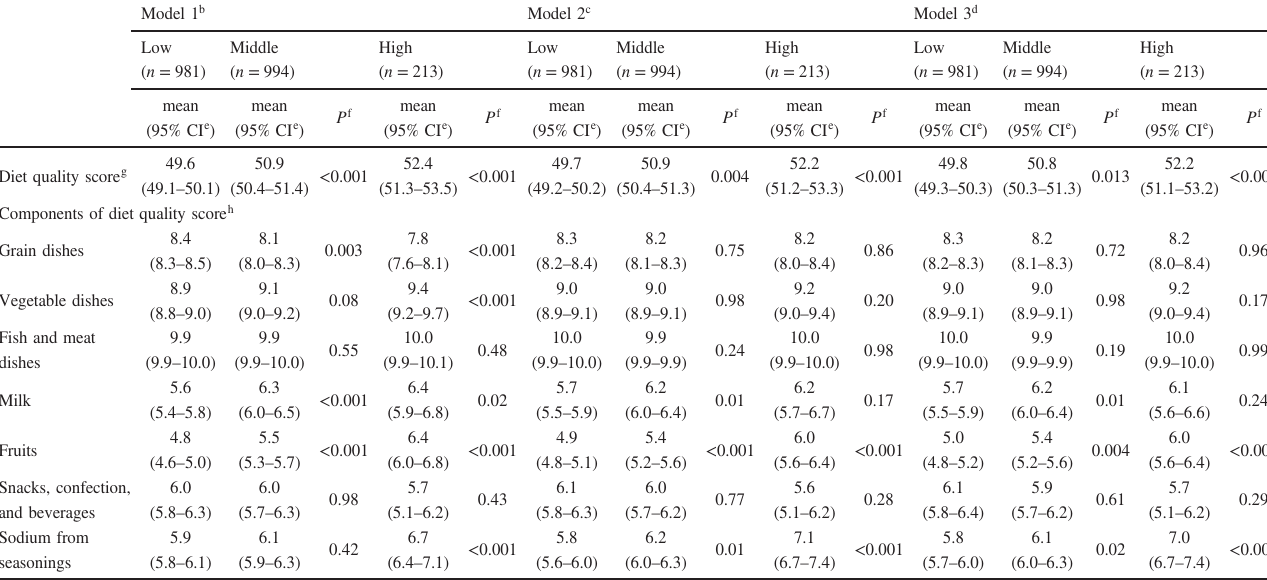
Table 3. Associations of education with components of diet quality score in older women ( n = 2,188)